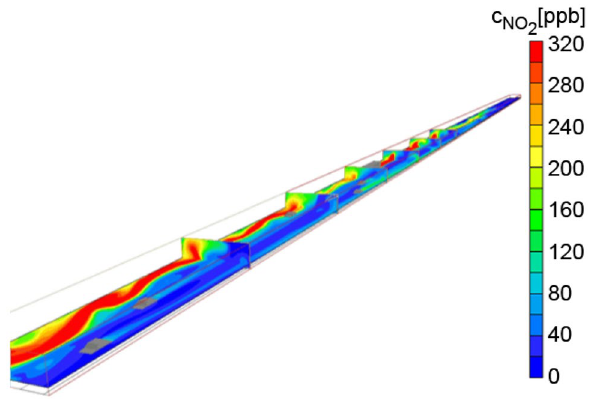
Fig. 4 Concentration profile simulation results at t = 29 s. Wave-like movement of the pollutants flow get more intense towards the tube exit. HDV emissions are considerably higher than LDV emis- sions